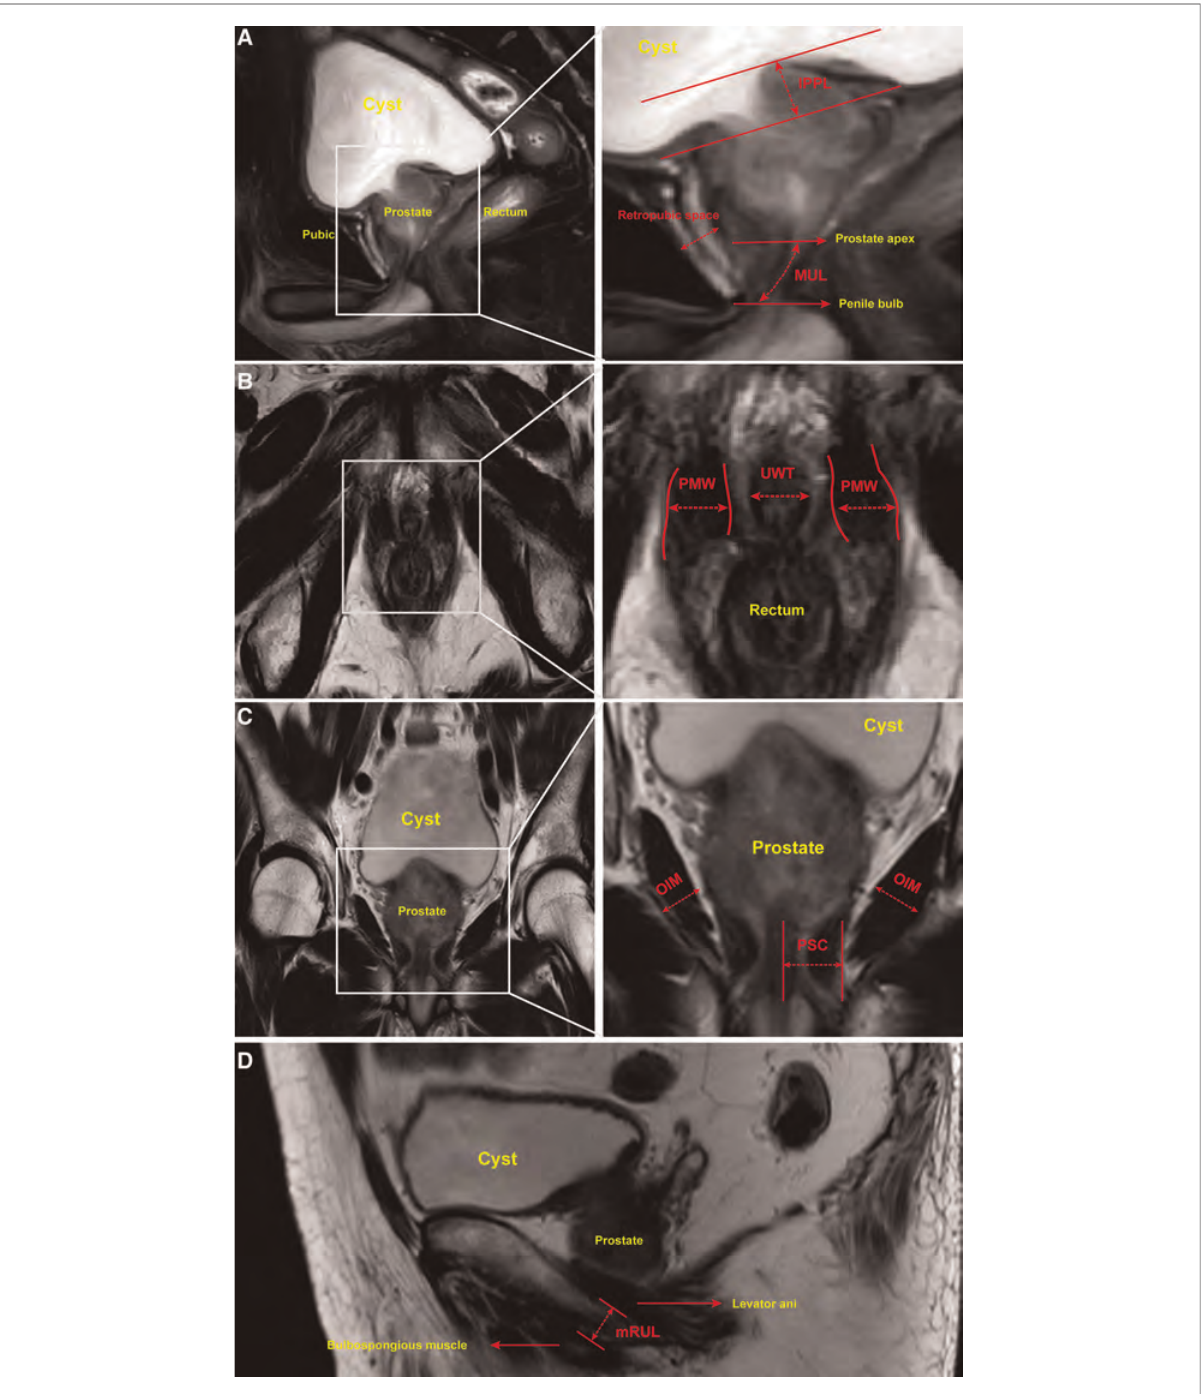
FIGURE 2 Urethral and pelvic anatomic parameters measured on MRI. Notes: ( A ) Sagittal T2-weighted sequences allowed for membranous urethral length (MUL) to be measured from inferior edge of the prostate apex to the superior margin of the penile bulb. Intravesical prostatic protrusion length (IPPL) was measured by the vertical distance from the tip of the protruding prostate to the base of bladder. Retropubic space was measured by the shortest distance between posterior margin of pubis and anterior of prostate. ( B ) Axial T2-weighted sequences allowed for puborectalis muscle width (PMW) and urethral wall thickness (UWT) to be measured. PMW was measured by the distance between inner and outer side of puborectalis muscle at the thickest portion. ( C ) Coronal T2-weighted sequences were used to measure peri-urethral sphincter complex (PSC) thickness and obturator internus muscle (OIM). ( D ) Minimal residual membranous urethral length (mRUL) was measured from the lower margin of the puborectalis muscle to the upper margin of the bulbospongiosus muscle in a direction parallel with the membranous urethra on Sagittal T2-weighted